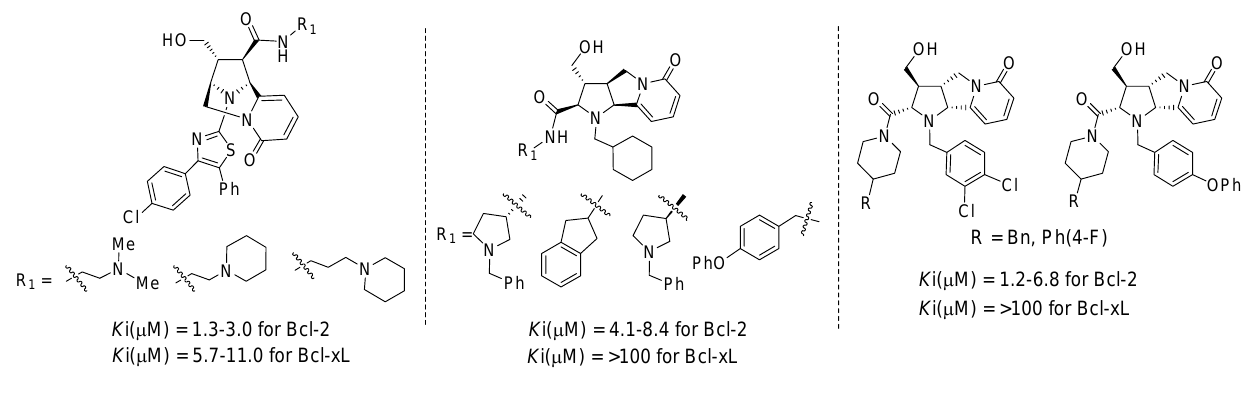
Figure 5. Discovery of selective inhibitors of Bcl-2 based on tricyclic pyridone scaffolds.